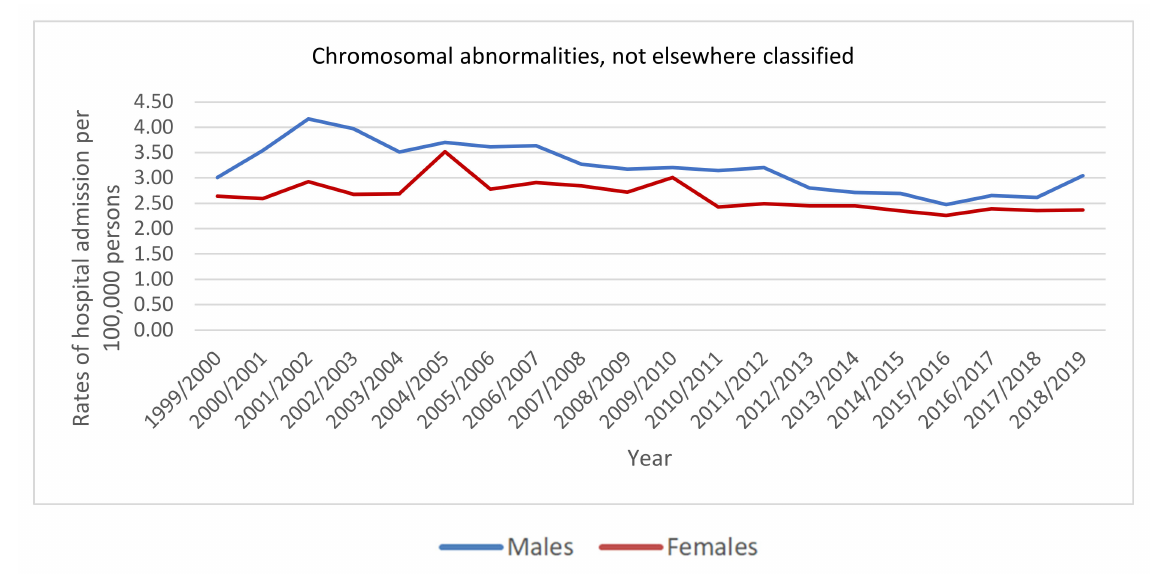
Figure 4. Hospital admission rates for congenital malformations, deformations and chromosomal abnormalities in England and Wales stratified by sex.